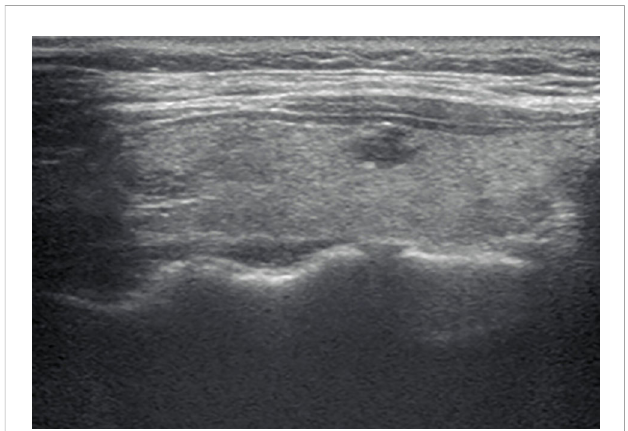
FIGURE 1 A longitudinal grayscale ultrasound (US) image obtained from a 37- year-old woman with papillary thyroid carcinoma shows a 7-mm solid, hypoechoic, and ill-de fi ned margin thyroid nodule with punctate echogenic foci. This nodule was classi fi ed as TR4C according to the Kwak and C thyroid imaging reporting and data system (TIRADS). The original TIRADS does not recommend biopsy, while the modi fi ed TIRADS suggests biopsy.